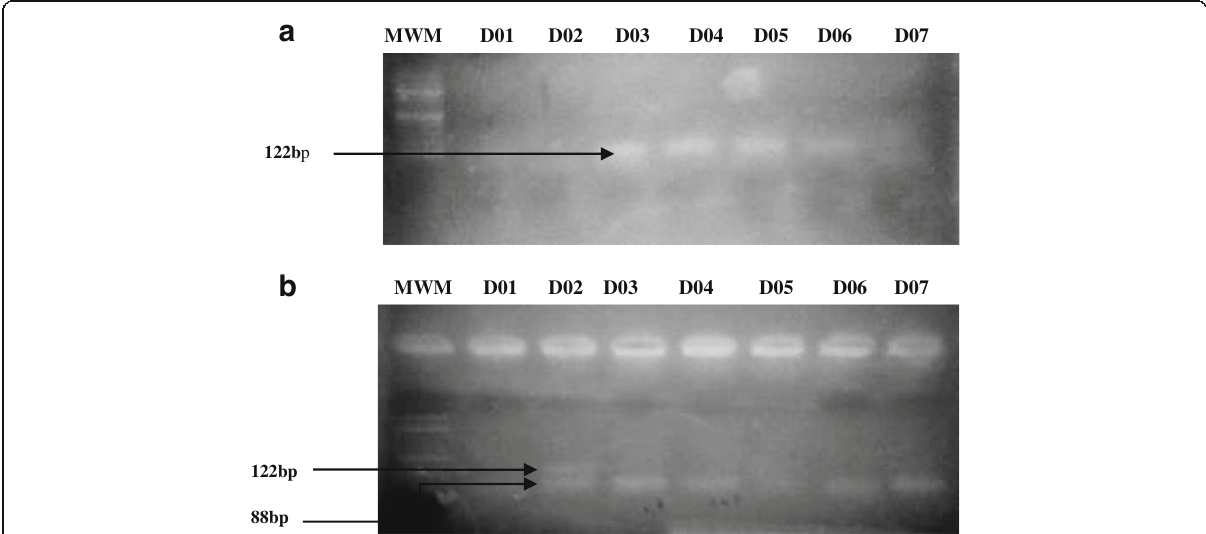
Fig. 1 RFLP-PCR of ABCC8 C49620T Polymorphism. a shows the presence of the amplified gene for D01-D07 at 122 bp. b shows the restriction digest products of the gene. A 122 bp indicates the T allele while a 88 bp indicates the C allele. Sample D01 and D03-D07 show the presence of the wild-type homozygote CC genotype while D02 shows the presence of the heterozygote CT genotype. MWM indicates 100 bp molecular weight marker